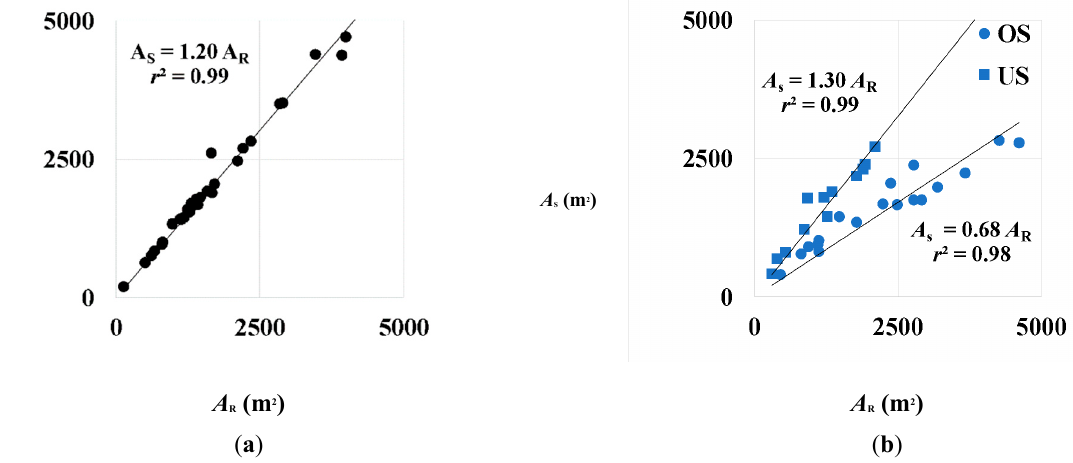
Figure 9. Performance in terms of surface estimation: surface as the output of the GEOBIA procedure, A S , of the 30 reference lakes vs. surfaces of digitized lakes, A R , for the images representing the arid ( a ) and the temperate ( b ) periods.